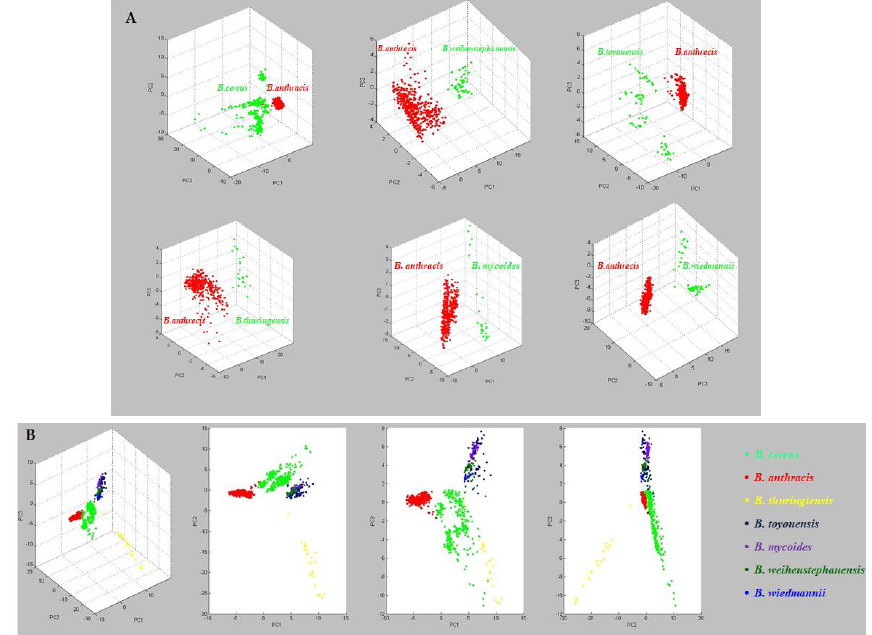
Figure 3. ( A ) Statistical comparison by PCA between mass spectra of B. anthracis and of other species belonging to the B. cereus group. ( B ) PCA grouped the analysed isolates into 7 different clusters. Table 1. List of the 12 ion peaks considered with their mass to charge ratio and the peak intensity average for each class and relative standard deviation. In bold are shown the higher intensities values for each mass peak, to be considered as characteristic ion peak for the